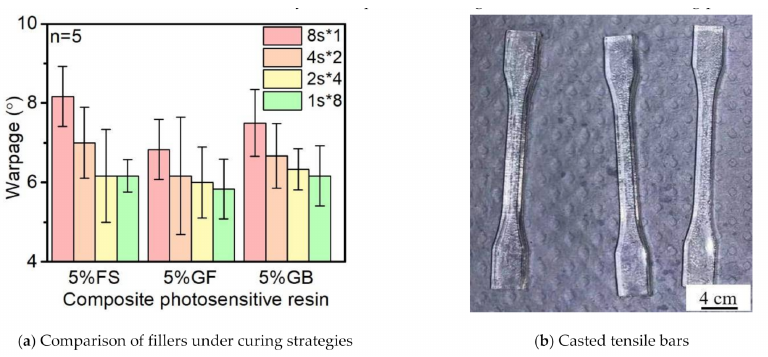
Figure 11. The warpage of the tensile bars with different